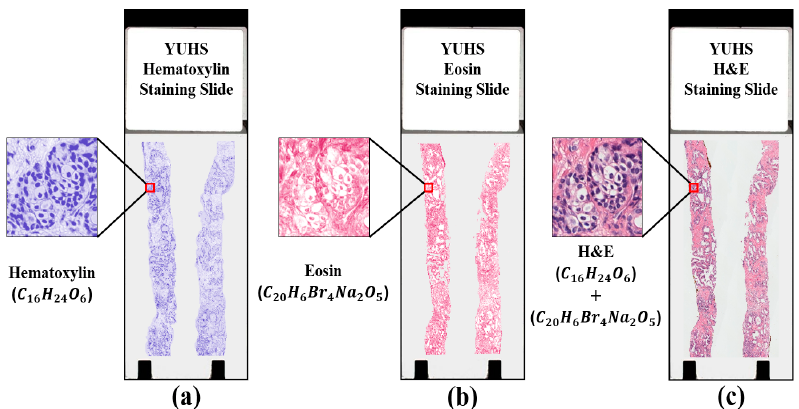
Figure 1. The visualization result of hematoxylin and eosin (H&E) staining slide. ( a ) Hematoxylin staining